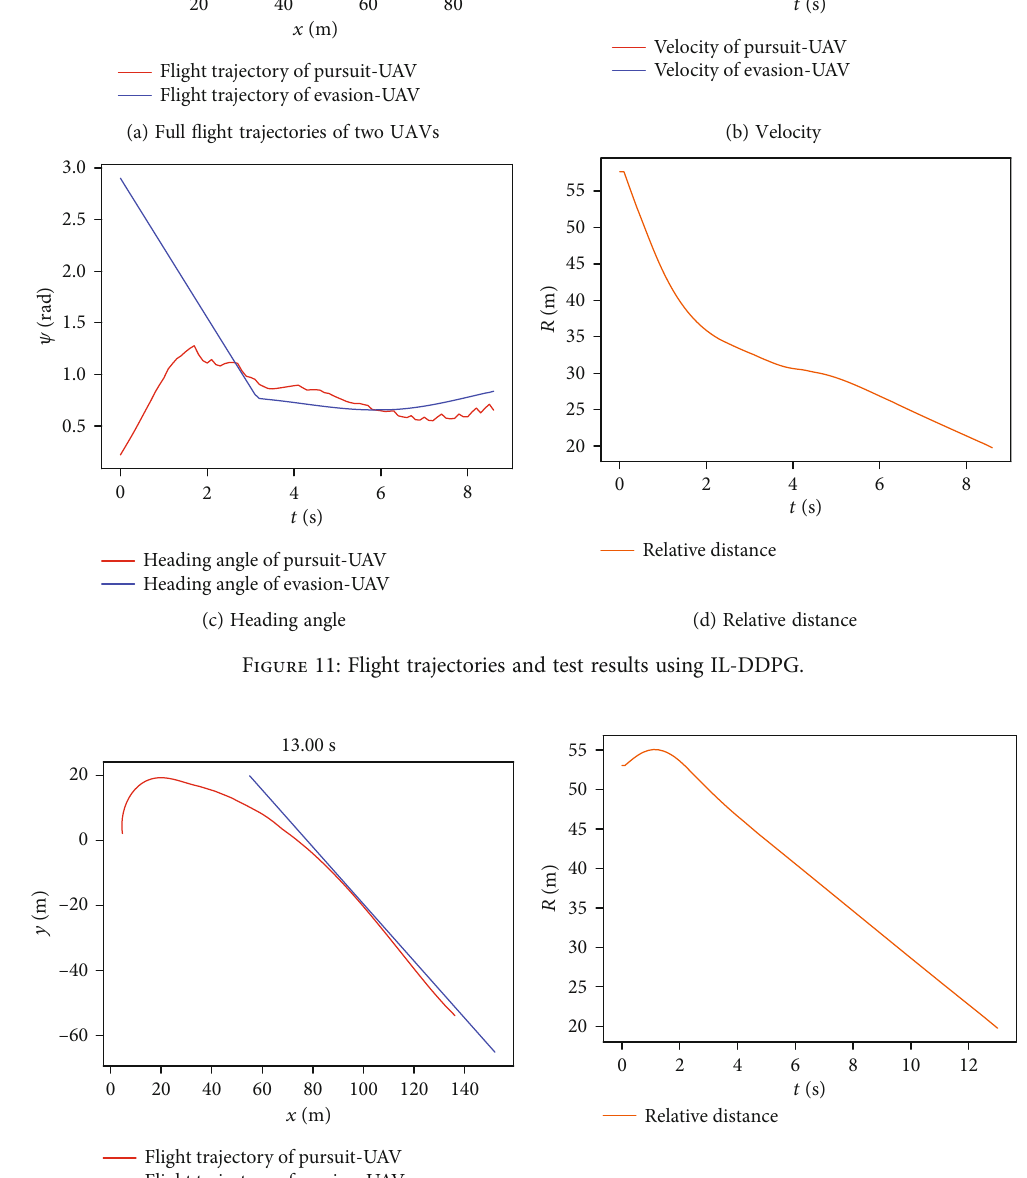
Figure 12: Trajectories of facing evasion-UAV with linear